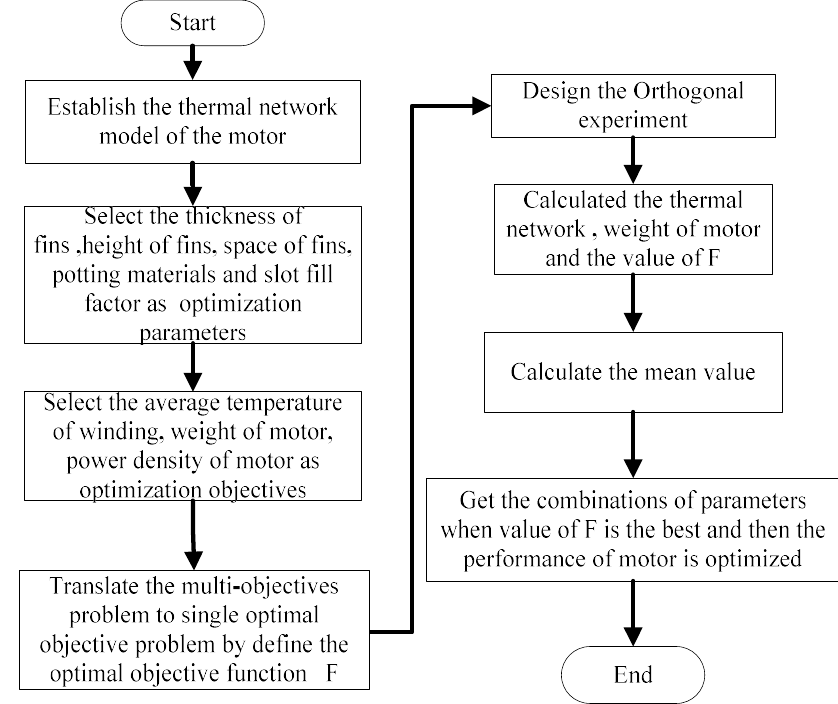
Figure 7. The flow chart of the multi-objective optimal design process of this motor and the flowchart of the optimal design by Taguchi.